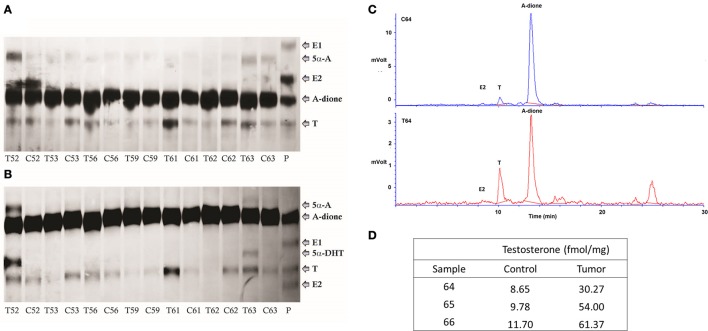
A-dione metabolism in the cancer and adjacent control endometrium. (A) Identification of the reaction products by autoradiography (TLC developed in cyclohexane/ ethyl acetate [1:1, v/v]) showing conversion of 3H labeled A-dione (80 nM) to testosterone (T) and 5α-androstanedione (5α-A) in cancer, T, and corresponding control, C, tissues. In placenta, P, A-dione was metabolized to T, E1, and E2. (B) Autoradiography of the same samples that were extracted from silica gel and developed in cyclohexane/ ethanol (95:5, v/v), confirming the presence of 5α-dihydrotestosteone (5α-DHT) in two EC samples. (C) HPLC profiles demonstrates metabolism of 3H labeled A-dione (8 nM) to T in control tissue and matched tumor tissue. (D) Formation of T (fmol/mg powdered tissue).